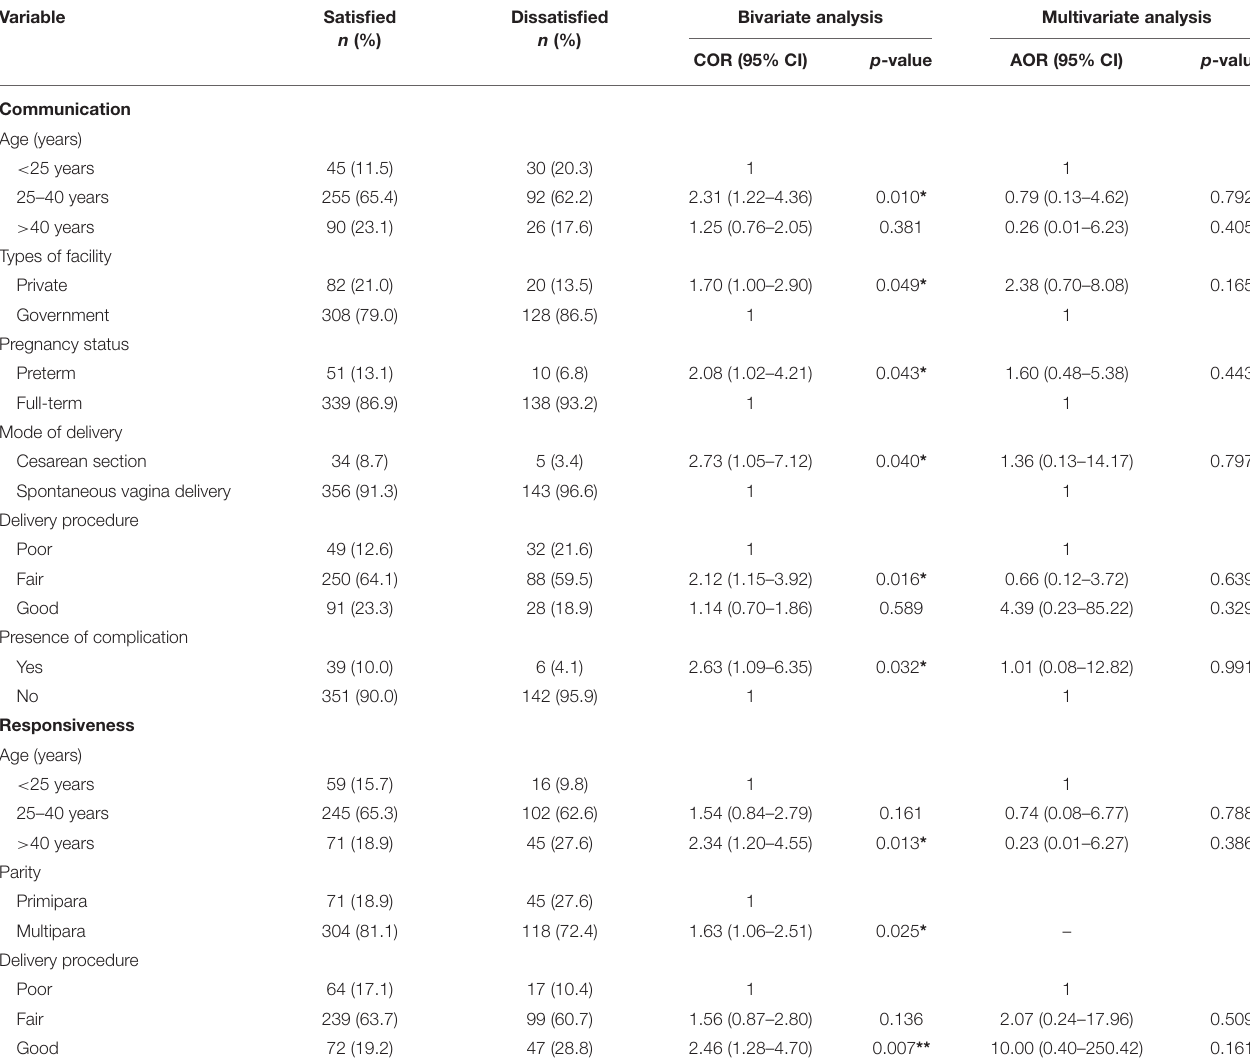
TABLE 3 | Factors associated with satisfaction of skilled delivery in the dimension of communication and responsiveness ( n = 538).